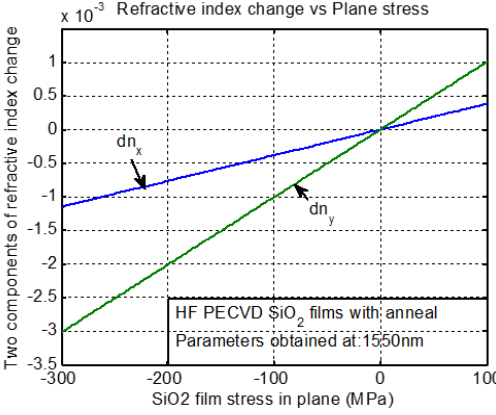
Figure 2. Relationship between birefringence and film stress at a wavelength of 1550 nm.